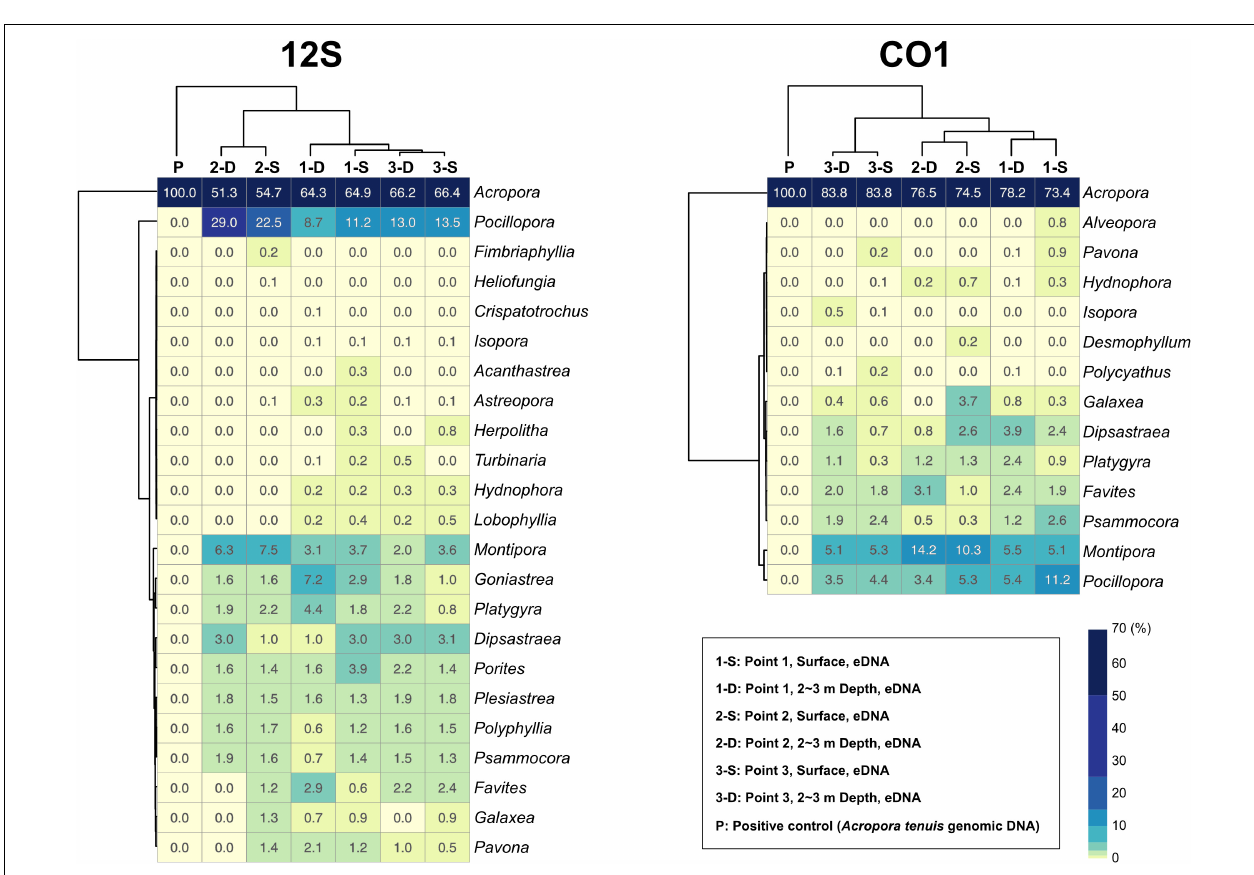
FIGURE 5 | Percentages of sequencing reads mapped to coral genera in each eDNA sample. 12S PCR amplicons are shown to the left and CO1 to the right. Percentages are colored in the heatmap. Each sample and coral genera were hierarchically clustered using the ward D method. Percentages for each coral genus are shown in each box, and numbers of mapped reads are available in Supplementary Tables 7 , 8